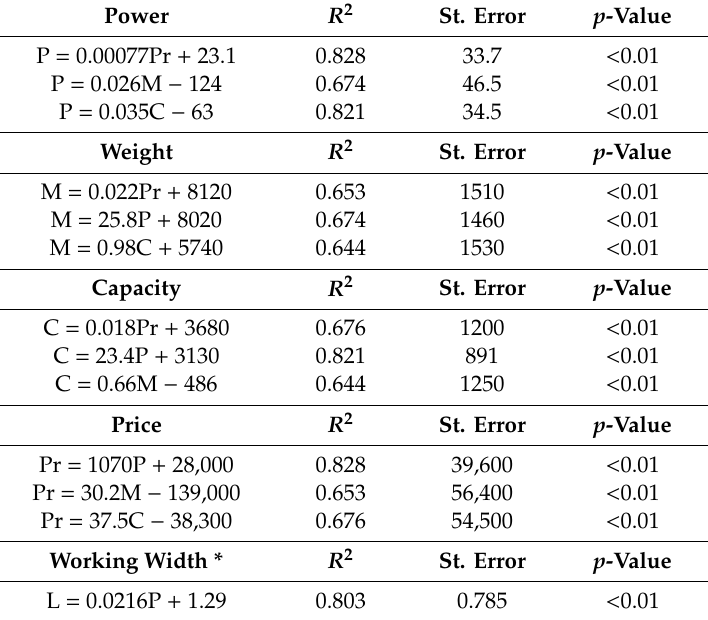
Table 3. Linear models for technical parameters and prices of combine